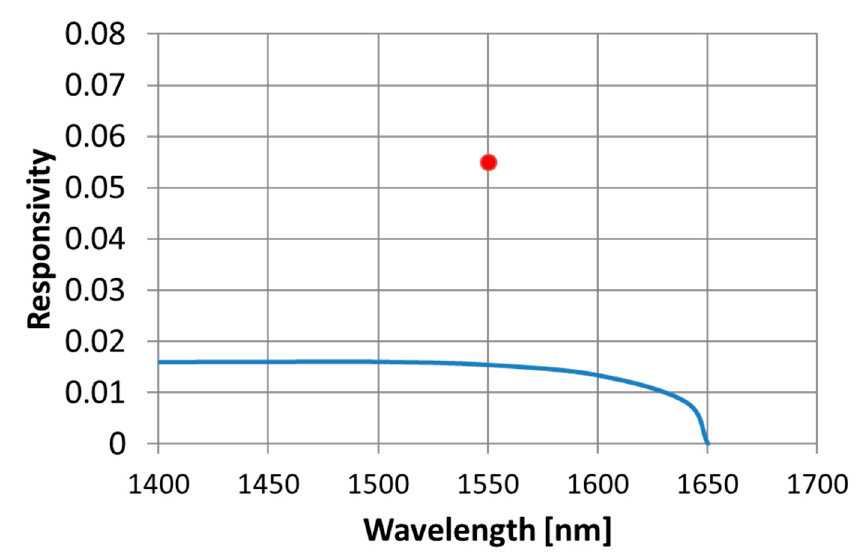
Figure 8. Current-voltage (I-V) curves for the dark current and photocurrent with avalanche multiplication [12].